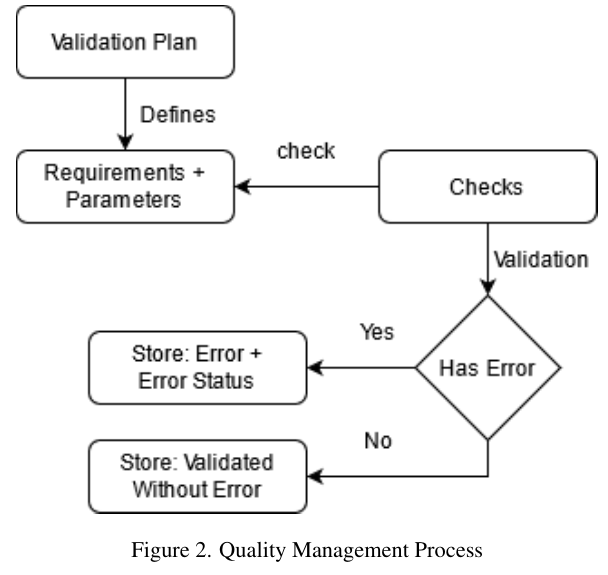
Figure 2. Quality Management Process